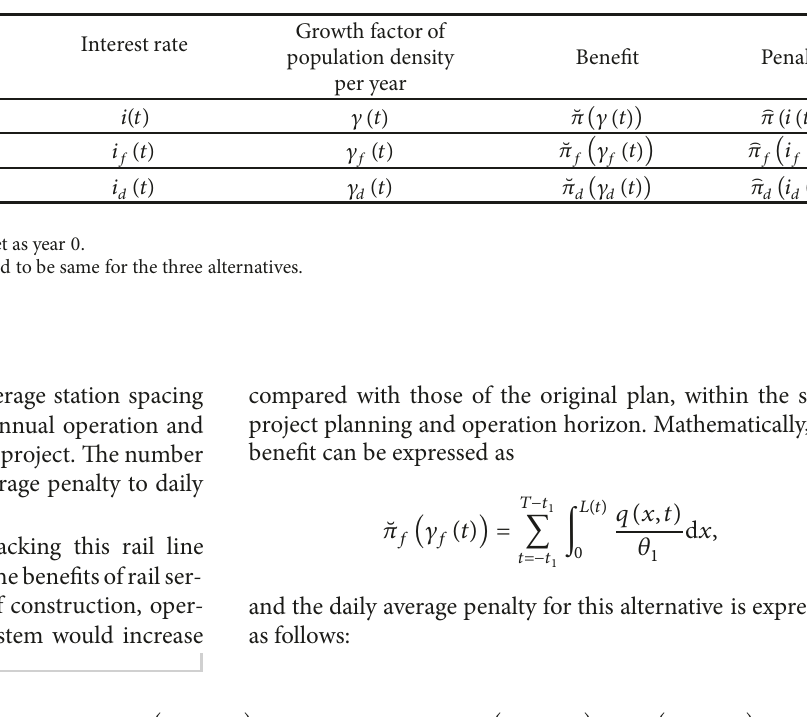
Table 2: The benefit and penalty of each